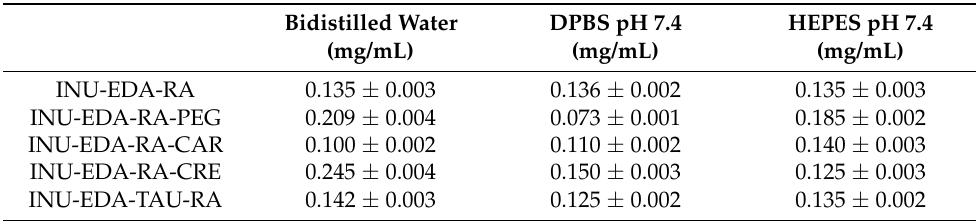
Table 2. Critical aggregation concentration (CAC) values reported in mg/mL ± standard error and calculated both in bidistilled water, DPBS pH 7.4, and HEPES pH 7.4 for each synthetized inulin-based amphiphilic